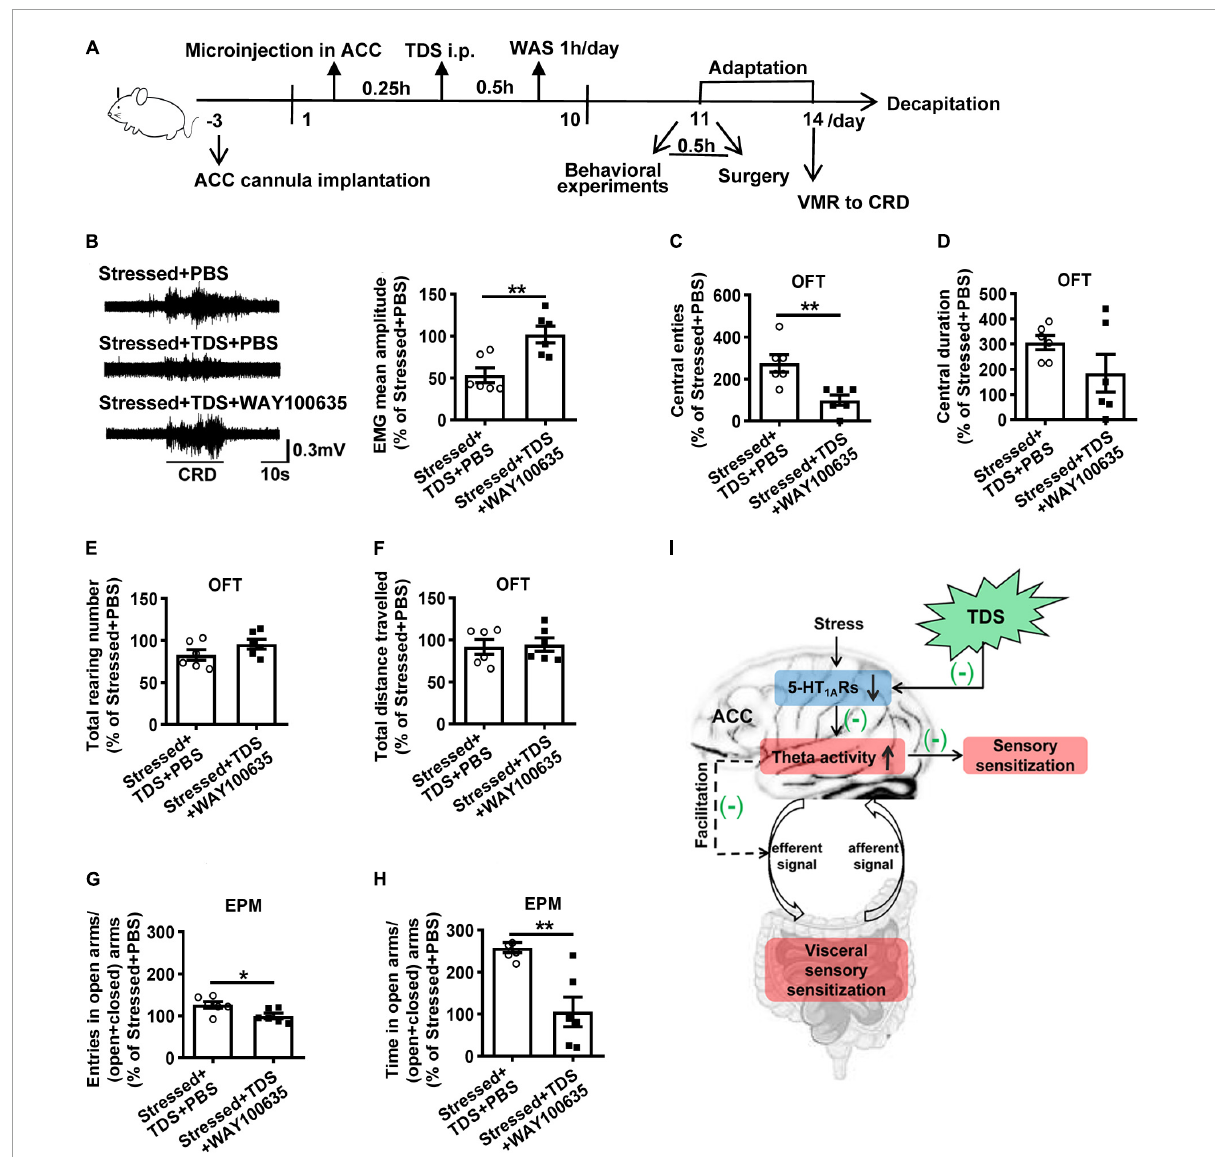
FIGURE5 The effects of TDS in stress-induced visceral hypersensitivity were mediated by 5-HT 1A Rs. (A) Experimental design. (B) The representative EMG of visceromotor response to 60 mmHg CRD (left) and the mean amplitude of EMG (right). Analysis of the central entries (C) , central duration (D) , the total raring number (E) , the total distance travelled (F) in the OFT. Analysis of the percentage of open arms entries (G) and the percentage of time spent into open arms (H) in the EPM. (I) Schematic summary of mechanisms underlies tandospirone alleviating visceral hypersensitivity induced by stress. Stress-induced 5-HT 1A R downregulation leads to ACC activity increase, which is expressed as theta oscillation enhancement responding to visceral extension. Increased theta oscillations may result from over-responsive ACC to visceral afferent stimuli, thus manifesting central pain sensitization. Besides, theta oscillations increase may trigger descending pathway facilitation, thus increasing visceral sensitivity in the colon and contributing to visceral hypersensitivity. TDS activates 5-HT 1A Rs and inhibits theta oscillation enhancement in ACC to ameliorate visceral hypersensitivity may via the above two pathways. ( n = 6 for Stressed + PBS, Stressed + TDS + PBS and Stressed + TDS + WAY100635 respectively). * p < 0.05, ** p < 0.01. Data are presented as means ±